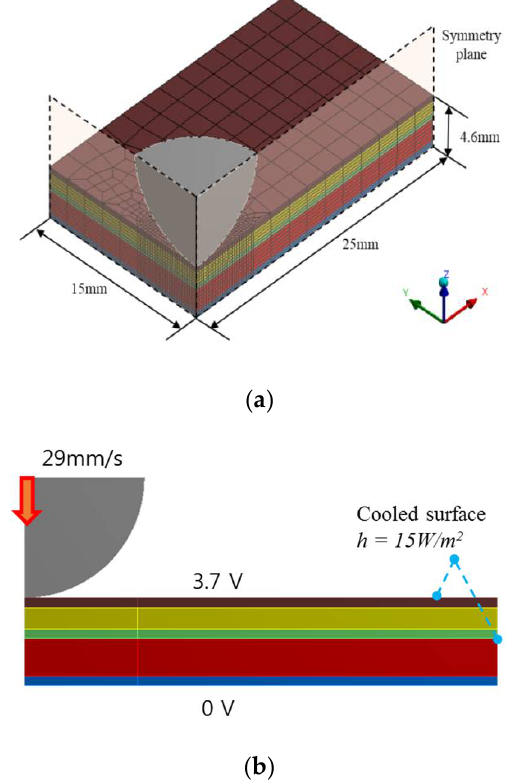
Figure 3. The representative sandwich (RS) model: ( a ) finite element model of LIB cell; ( b ) boundary conditions.